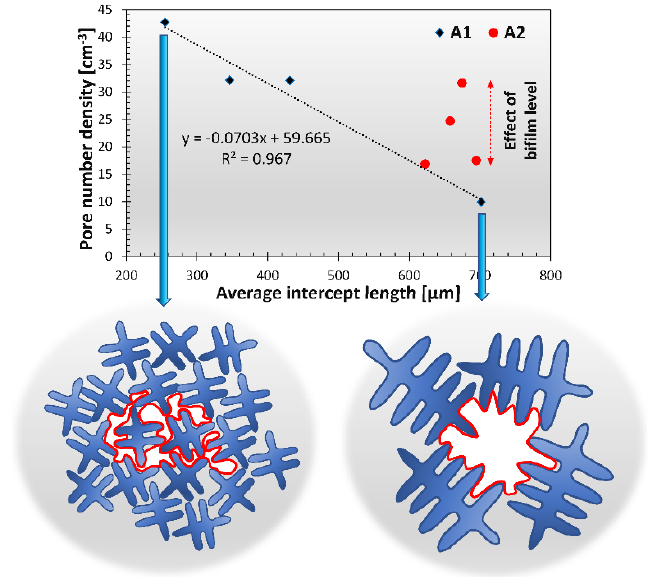
Figure 17. Comparison of pore number density and average intercept length (grain size) results.